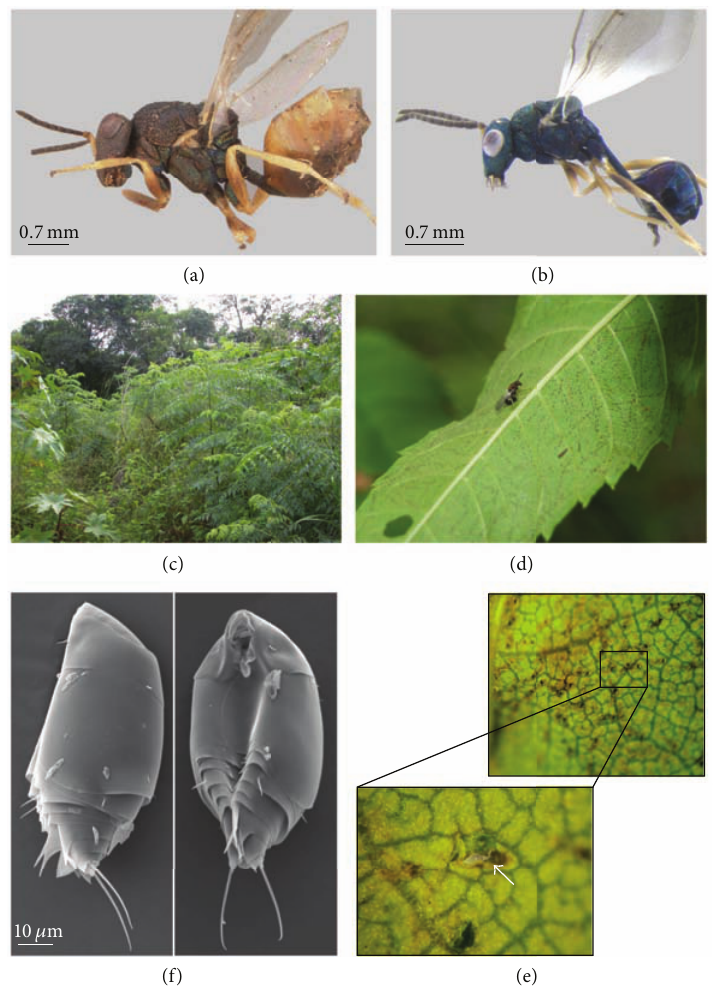
Figure 8: Orasema aenea : (a) habitus (female); (b) habitus (male). Biology and immature stage of O. aenea : (c) habitat; (d) female of O. aenea ovipositing on leaf of Tecoma stans ; (e) underside of leaf of T. stans with incisions (magnified area with egg extracted from incision); (f) planidia (lateral and